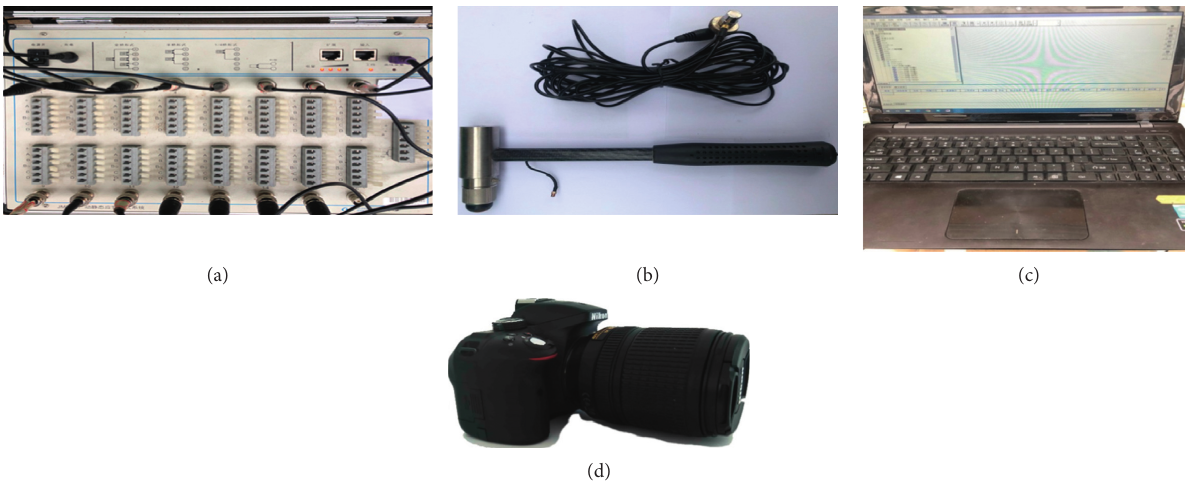
Figure 4: Experimental instruments. (a) Data acquisition system. (b) Excitation hammer/sensors. (c) Computer. (d) Digital video